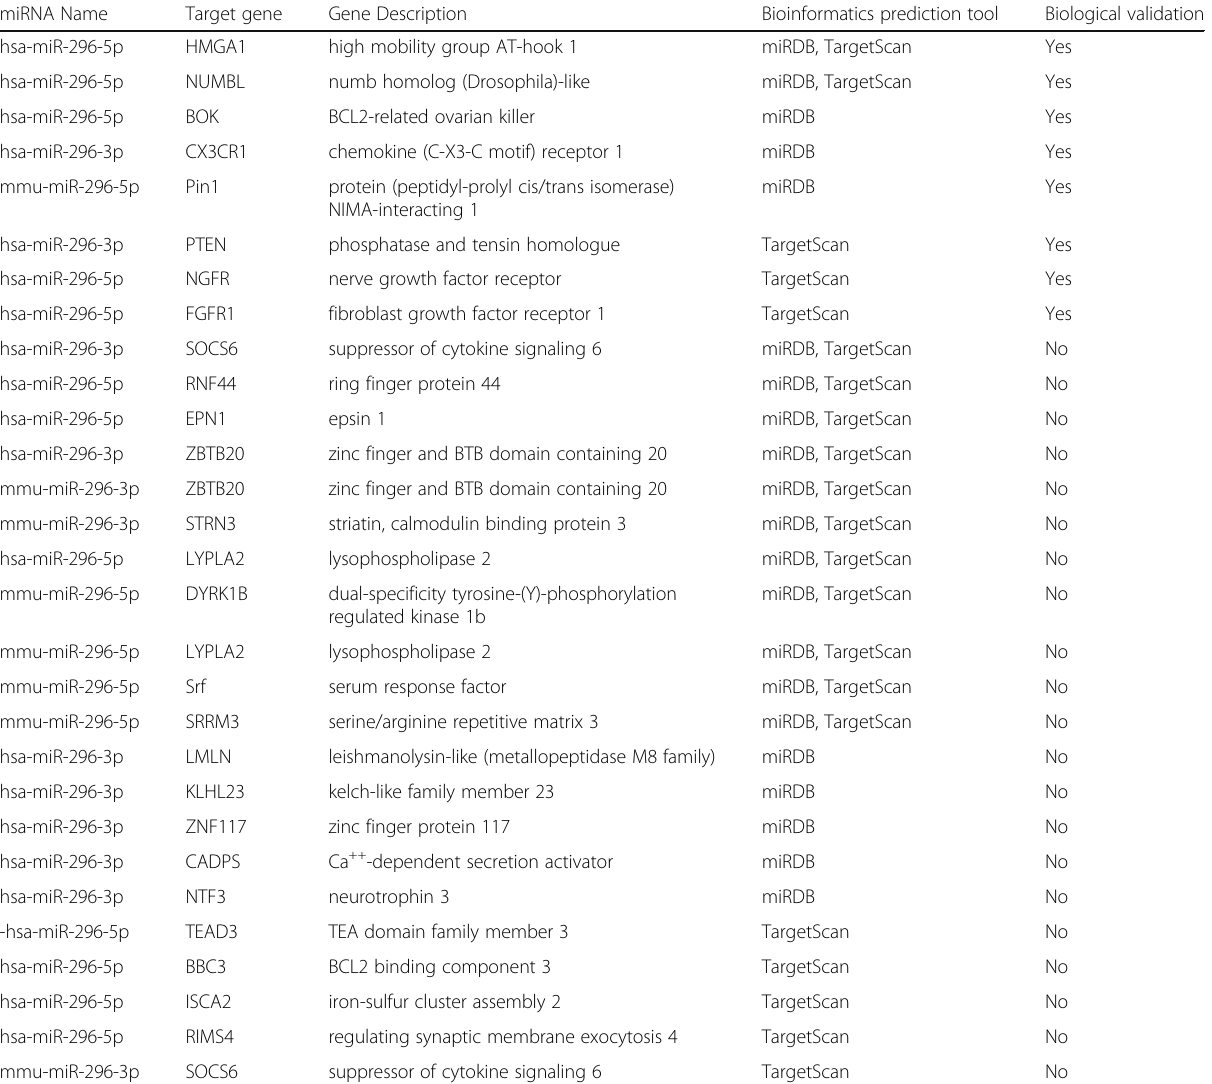
Table 1 Bioinformatics targets of miR-296 that were predicted and biologically validated in human and mouse miRNA